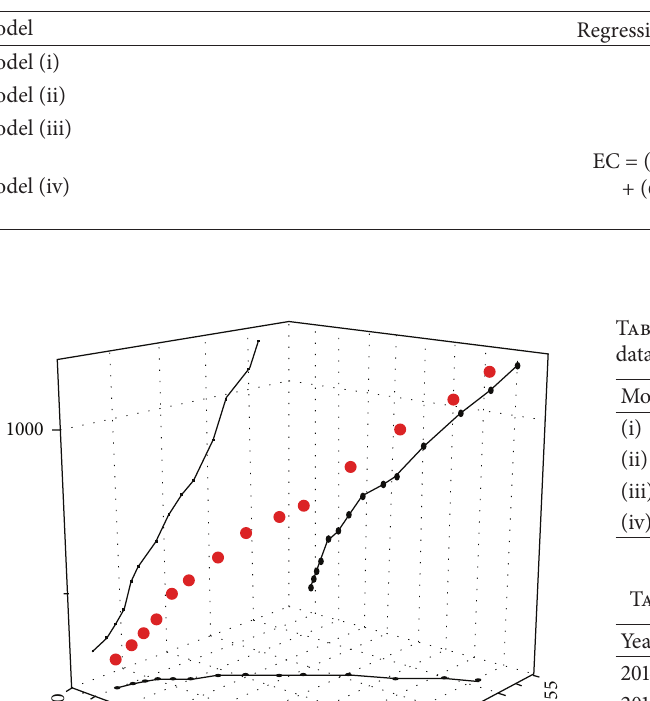
Table 3: Summary of regression results for four proposed models.